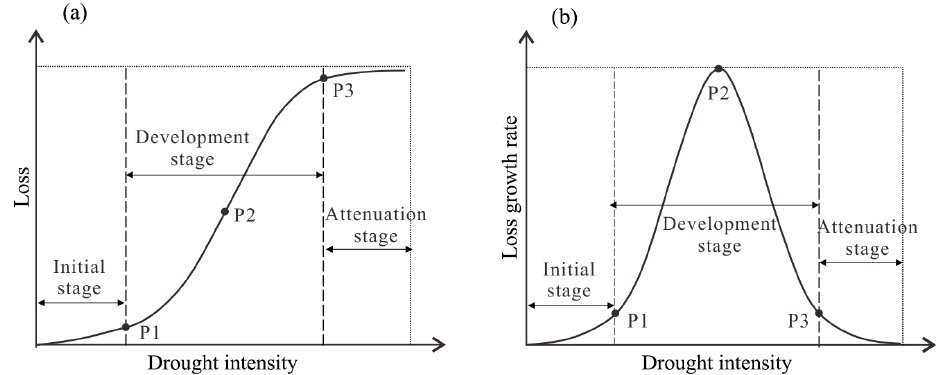
Figure 1. The relationship between drought intensity and (a) loss and (b) loss growth rate as shown by the S-shaped drought vulnerability curve. P1, P2, and P3 represent the starting point, inflection point, and end point of the rapid loss growth,